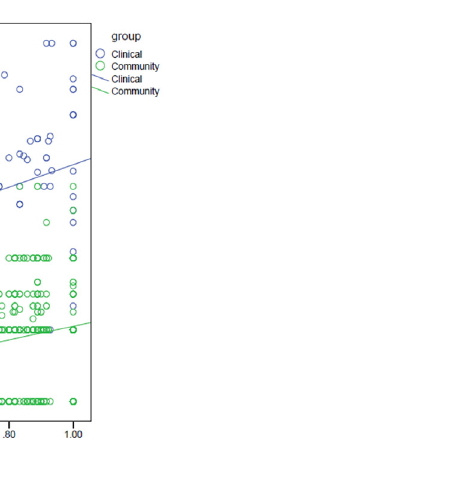
Fig 2. Association between attributional biases and level of delusional